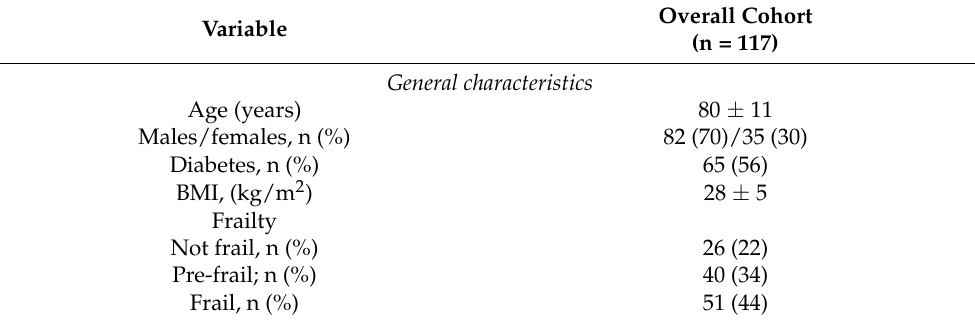
Table 1. General cohort